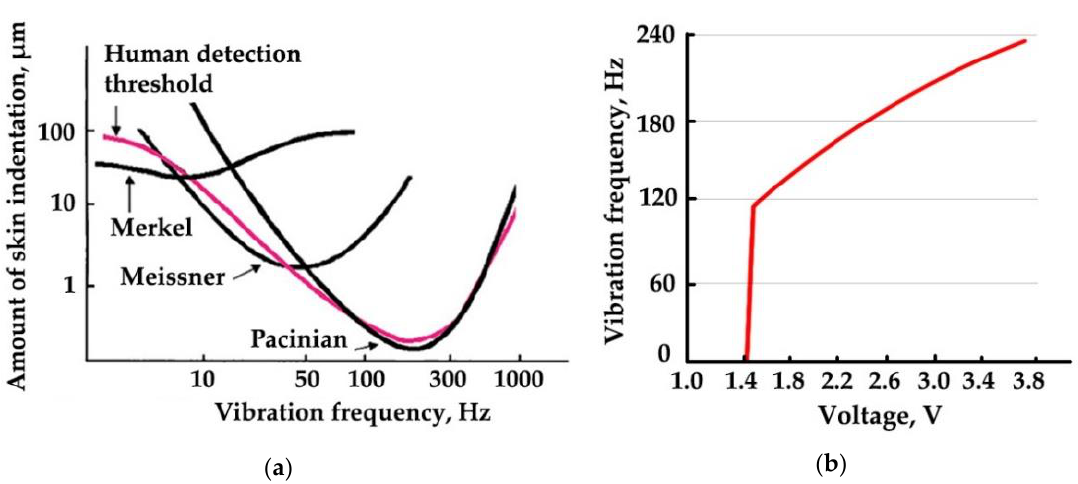
Figure 5. Human haptic sensitivity and vibration motor characteristics: ( a ) Psychophysically Figure 5 . Human haptic sensitivity and vibration motor characteristics: (a) Psychophysically determined thresholds for detection of di ff erent frequencies of vibrotactile stimulation (adapted determined thresholds for detection of different frequencies of vibrotactile stimulation (adapted from from [82]); ( b ) Vibration motor performance (adapted from [82]); (b) Vibration motor performance (adapted from [70]).